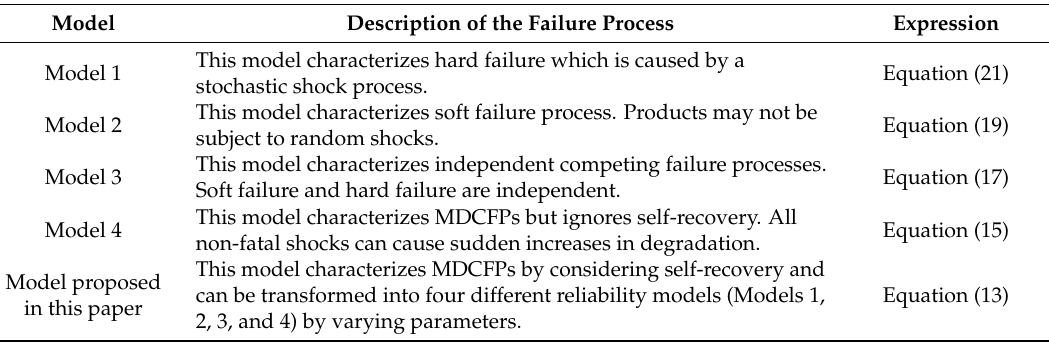
Table 1. Reliability